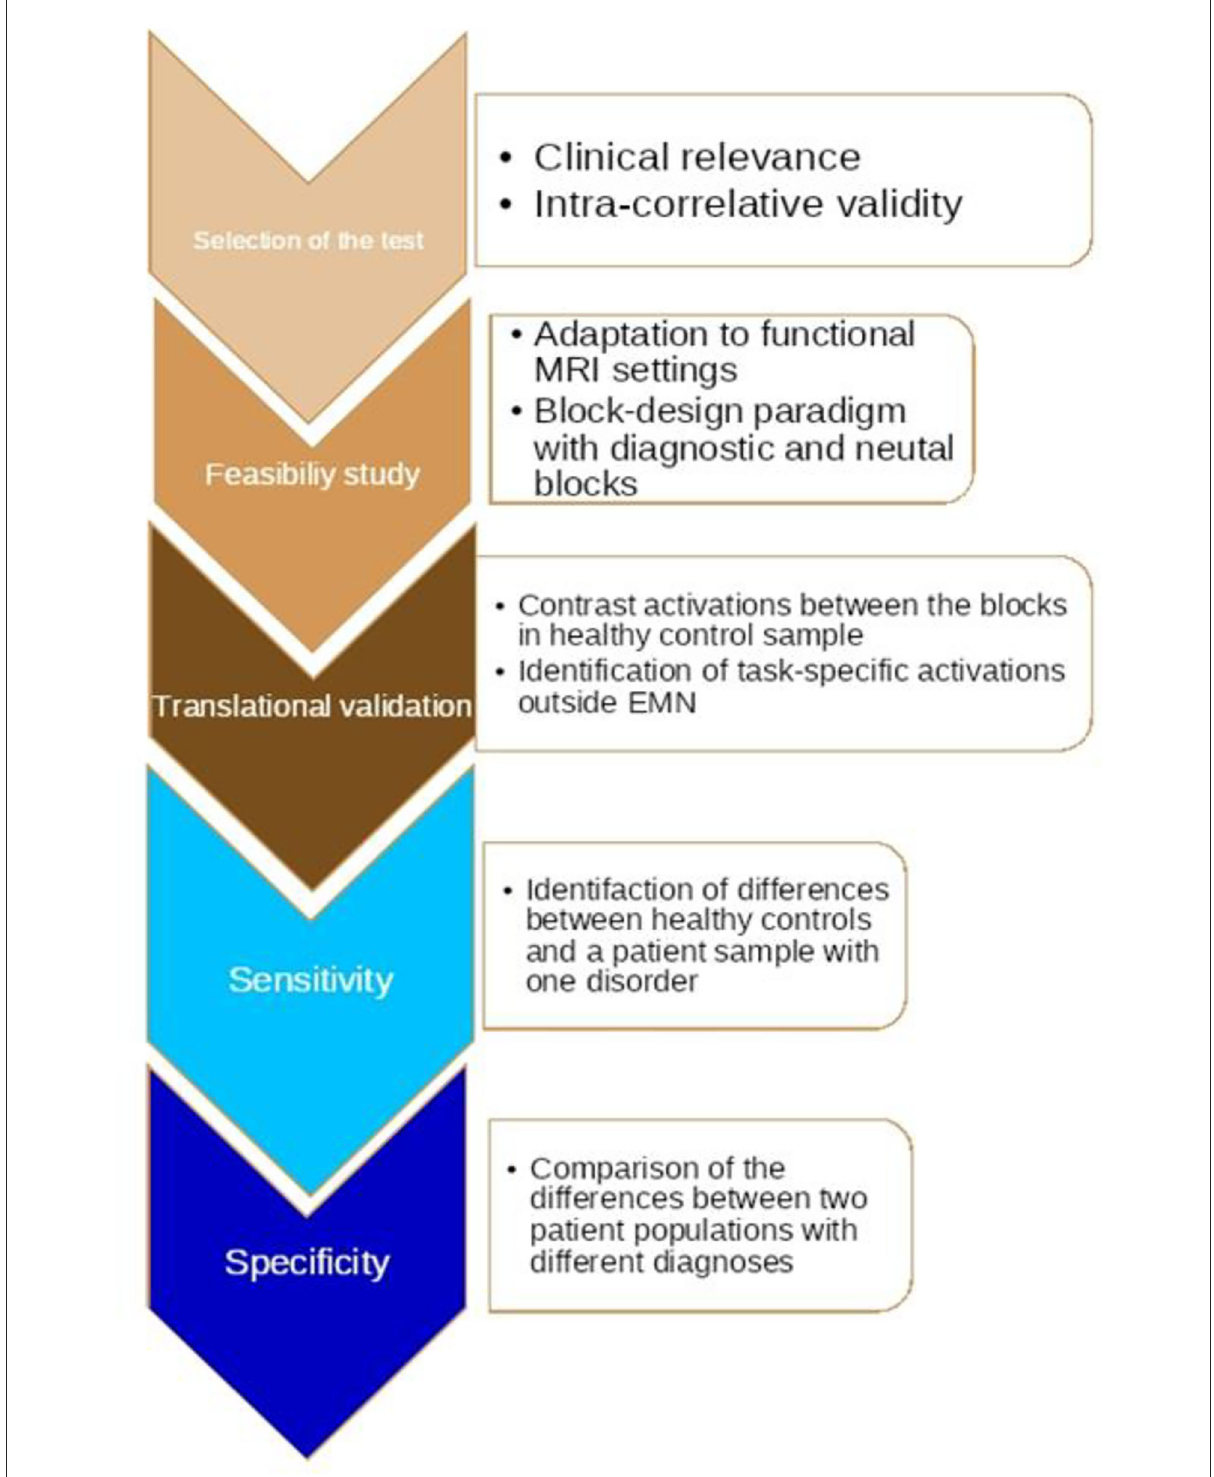
FIGURE3 The algorithm of translational